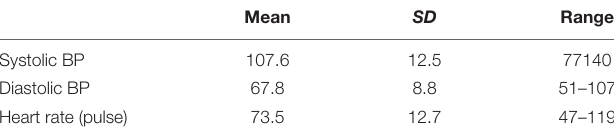
TABLE 4 | Descriptive information for the physiological